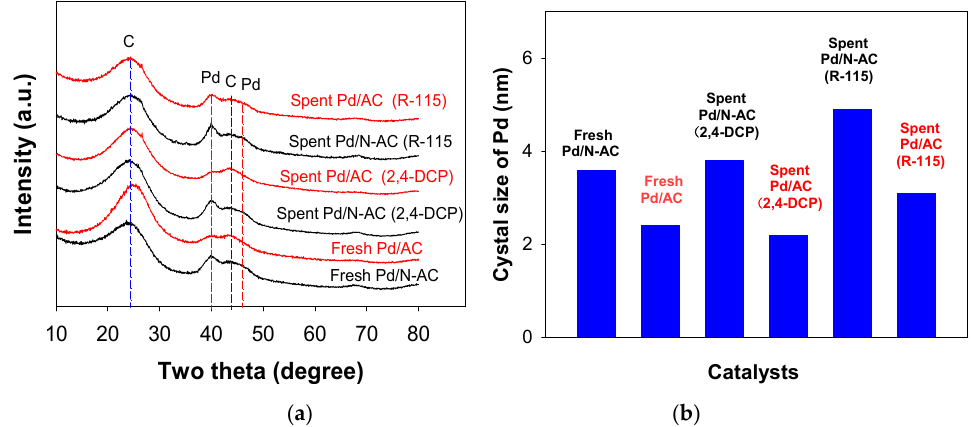
Figure 3. ( a ) XRD patterns of fresh and spent catalysts and ( b ) crystal size of Pd of different catalysts calculated based on the Scherrer’s equation along <111> direction.